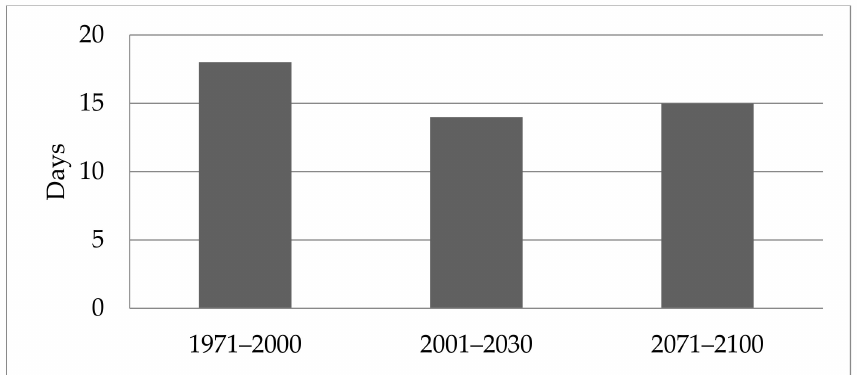
Figure 4. The duration of the flowering of spring barley over the baseline (1971–2000) and in the projected climate scenarios (2001–2030 and 2071–2100).